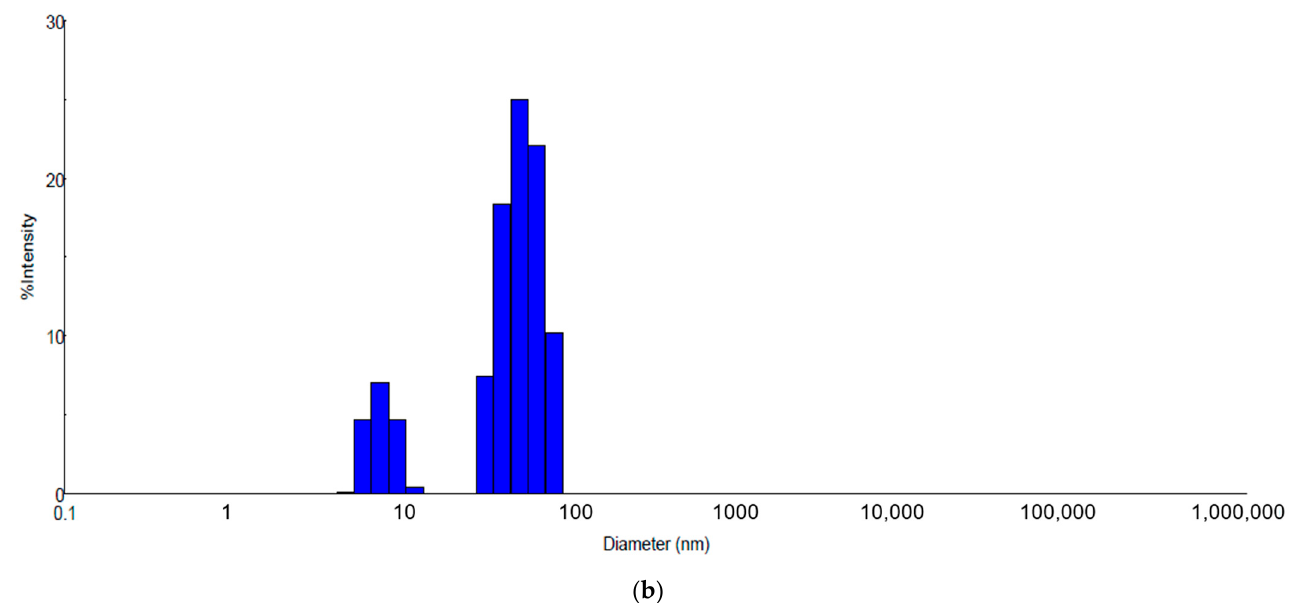
Figure 11. DLS images for samples named HT1 ( a ) and HT4 ( b ) obtained by solvothermal method, after 8 months .